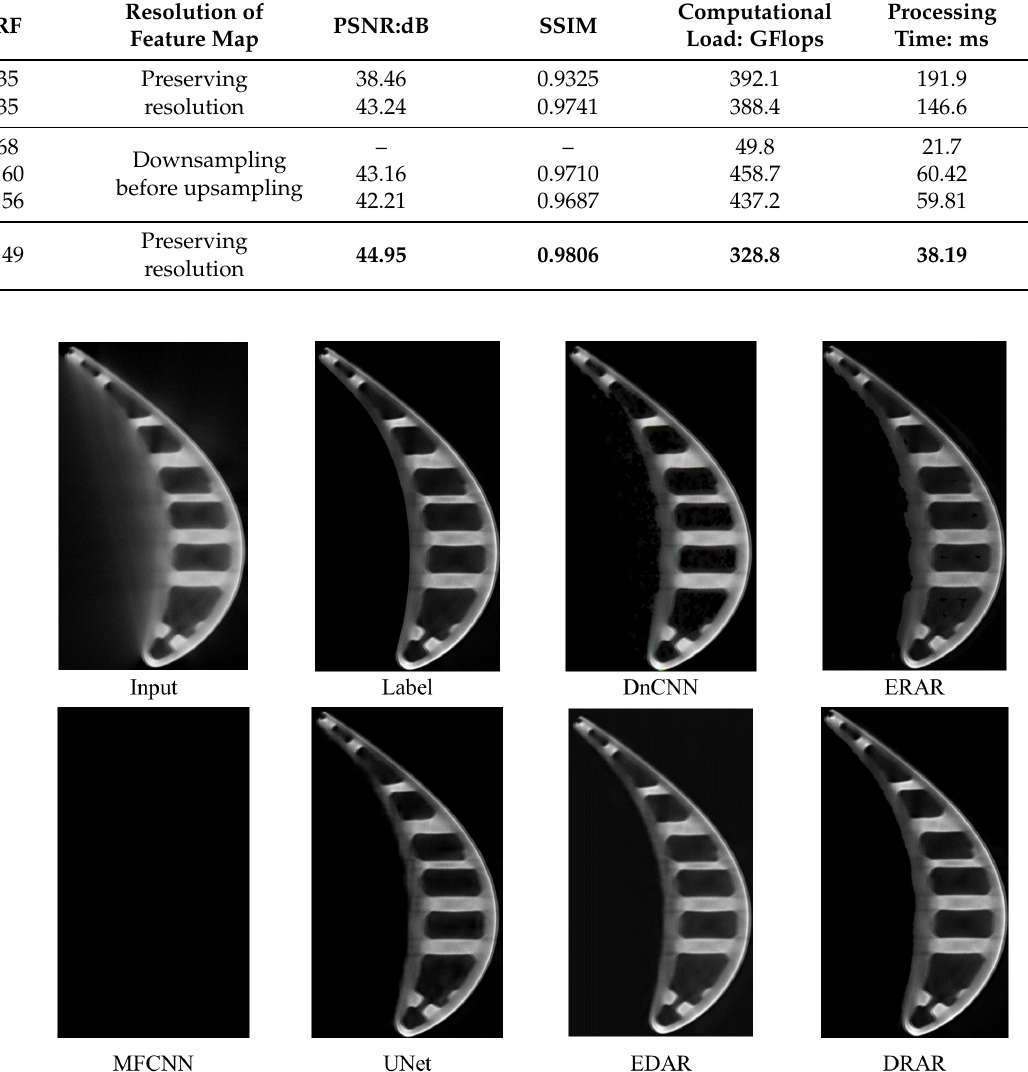
Figure 15. Visual results of DnCNN, ERAR, MFCNN, UNet, EDAR, and DRAR; the results of MFCNN are all zeros. Enlarged for best